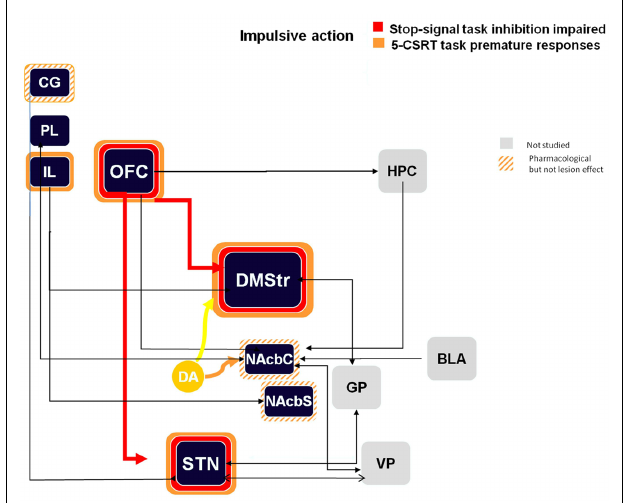
FIGURE 2 | Schematic representation of the impulsive action and perseveration/compulsivity processes in the stop task and the 5-CSRTT (premature responses and perseverative responses) from lesion and pharmacological manipulations. Colored bands surrounding each structure highlight the impulsive-like effect of the lesion of the given structure. Hatched–shaded bands indicate no effect of excitotoxic lesion, but an effect under pharmacological manipulation or other conditions). Gray structures indicate that no information is available. Arrows materialize anatomical connections between regions. CG, cingulate cortex; PL, pre-limbic cortex; IL, infra-limbic cortex; OFC, orbito-frontal cortex; HPC, hippocampus; DMStr, dorso-medial striatum; NAcbC, nucleus accumbens core; NAcbS, nucleus accumbens shell; GP, globus pallidus; BLA, basolateral amygdale; STN, subthalamic nucleus;VP, ventral